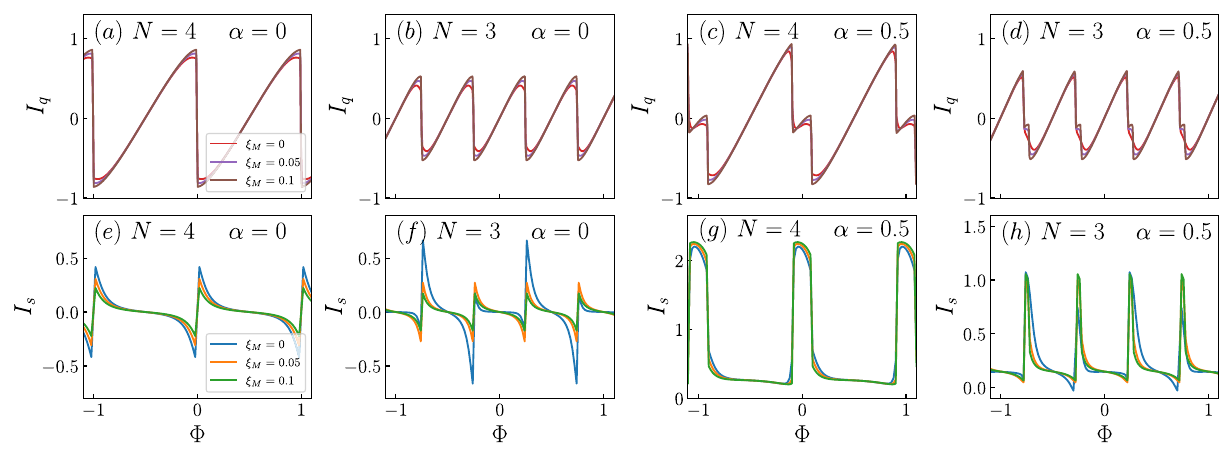
Figure 5. Charge and spin persistent currents, I q and I s respectively, for (cid:31) 1 = 0.1, (cid:31) 2 = 0 . The number of sites, N , and the Rashba spin-orbit coupling, α , are indicated in the figures. The coupling between MZMs, ξ M , is indicated by coloured lines, shown in the leftmost panels.